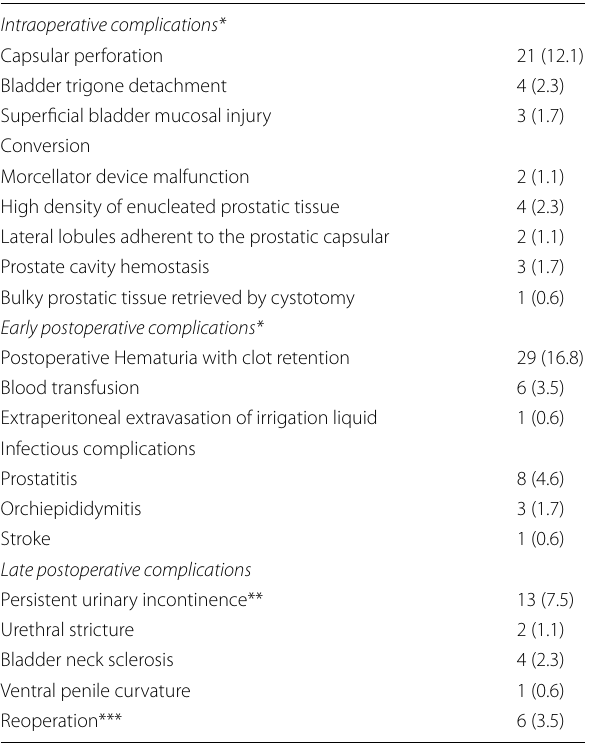
Table 3 Intra and postoperative